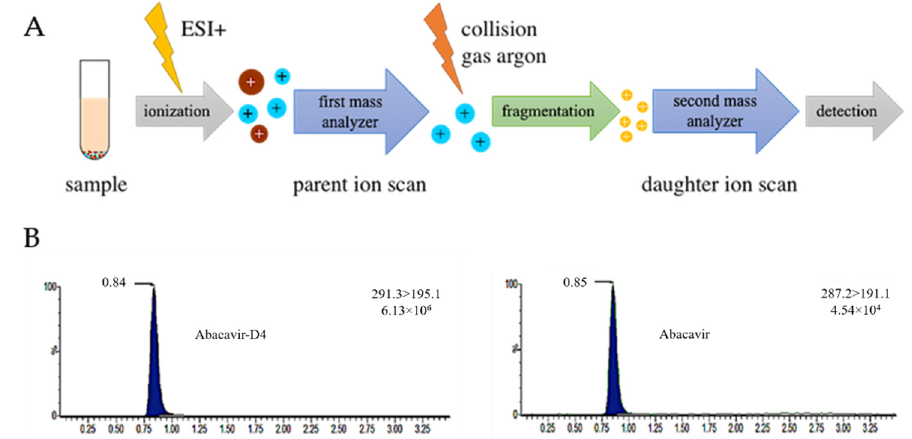
Figure 1. MS/MS method for the detection of ABC. ( A ) Principle of a tandem mass spectrometer. ( B ) MRM chromatograms of the first mass transition for analyte quantification of ABC-D 4 and ABC.